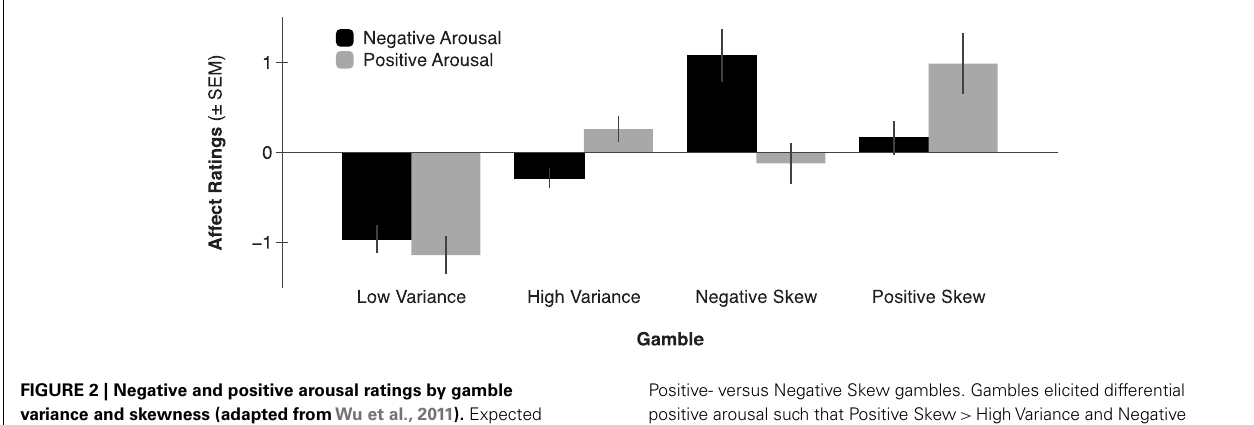
FIGURE 2 | Negative and positive arousal ratings by gamble variance and skewness (adapted fromWu et al., 2011). Expected value was held constant across all four gambles, while variance was equated across HighVariance, Negative Skew, and Positive Skew gambles, and skewness was manipulated in opposite directions for